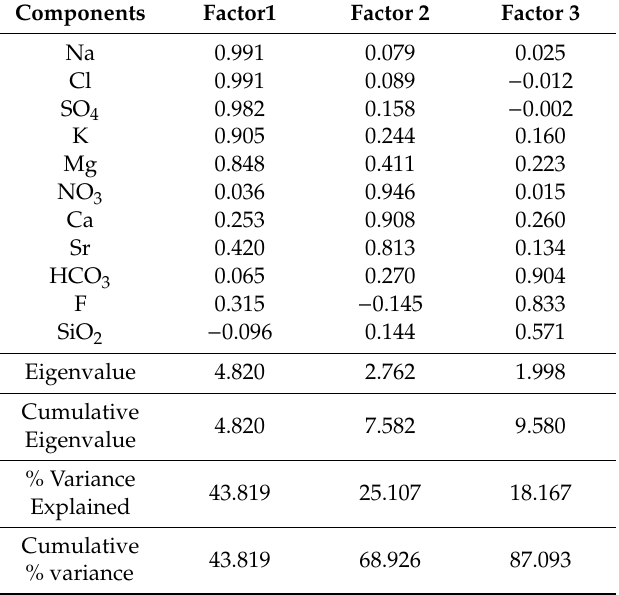
Table 4. Equimax factor matrix of geochemical composition and factor scores of groundwater and spring water